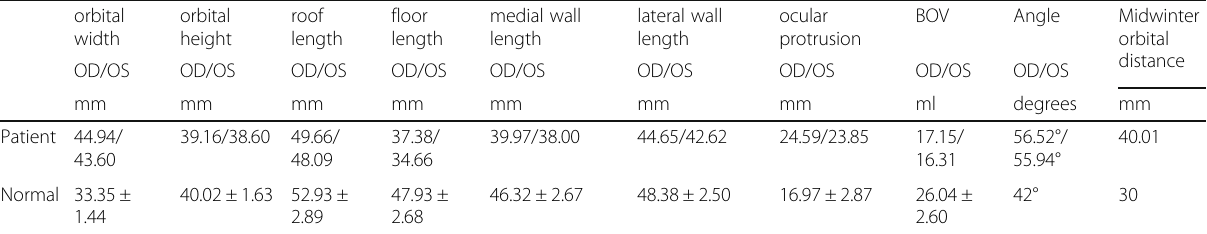
Table 1 Quantitative morphometry of the orbit in Crouzon syndrome patient and normal population [12] orbital width